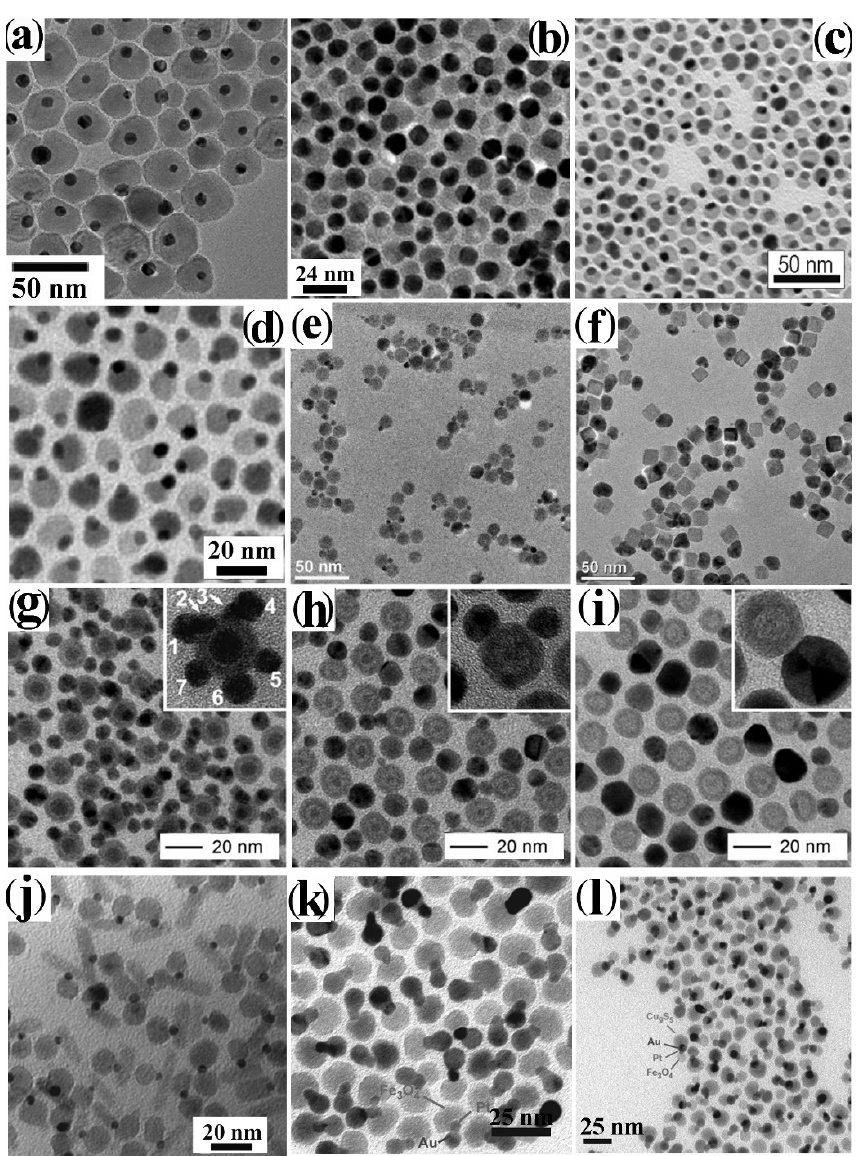
Figure 7. Gallery of representative heteromeric CNHSs obtained by direct heterogeneous nucleation-growth over preformed seeds (cf. Scheme 3a). The panel show TEM images of: ( a ) peanut-shaped Au–MnO hetero-dimer CNHSs (adapted with permission from Ref. [218], Copyright 2008, American Chemical Society); ( b ) dumbbell-like Au–Fe 3 O 4 hetero-dimer CNHSs (reproduced from Ref. [241] with permission, copyright American Chemical Society); ( c ) Peanut-shaped FePt–In 2 O 3 hetero-dimer CNHSs with cubic-shaped FePt domains (reproduced with permission from Ref. [250], Copyright 2011, American Chemical Society); ( d ) Peanut-shaped Pt–Fe 3 O 4 hetero-dimer CNHSs (adapted with permission from Ref. [234], Copyright 2010, American Chemical Society); ( e , f ) asymmetric Fe 3 O 4 –Ag hetero-dimer CNHSs (reproduced with permission from Ref. [217], Copyright 2008, Wiley-VCH Verlag GmbH & Co. KGaA); ( g – i ) conversion of Fe@Fe x O y –Ag heteromer CNHSs to